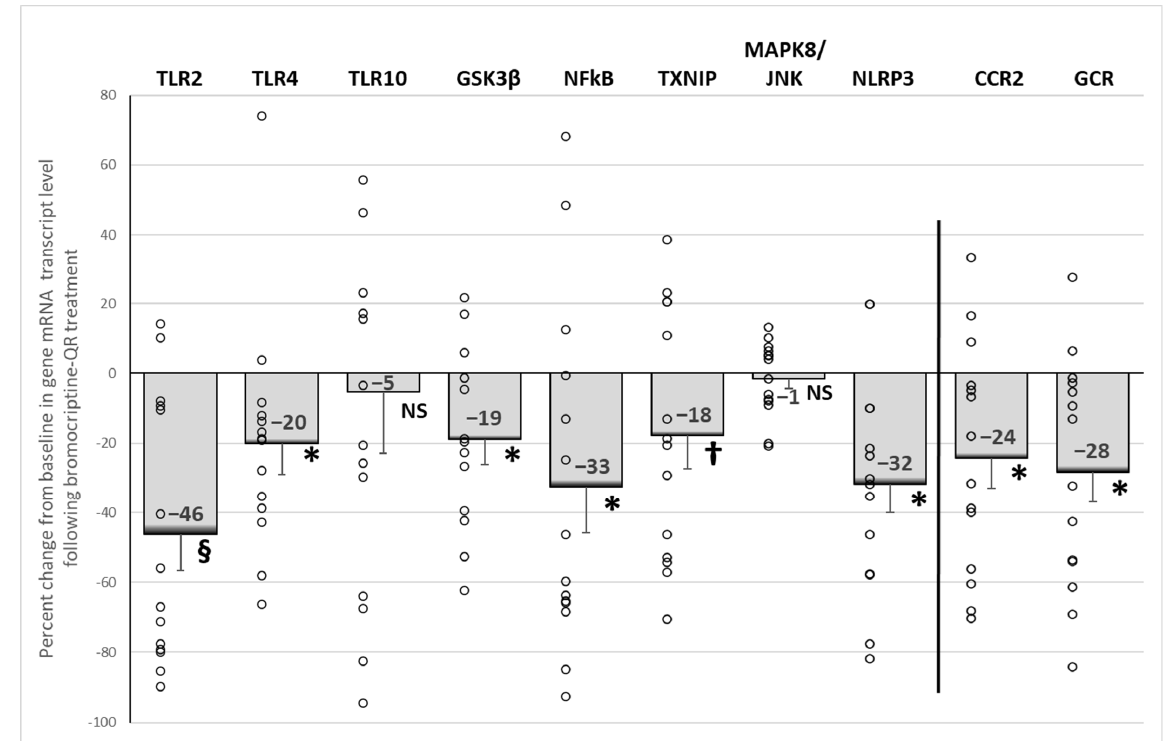
Figure 5. Effect (change from baseline) of 4 months of bromocriptine-QR treatment on PBMC Pro-inflammatory gene mRNA level. * Significant, 2-tailed t -test; † Significant, 1-tailed t -test; § Significant, Wilcoxon signed rank test; NS, Not Significant.